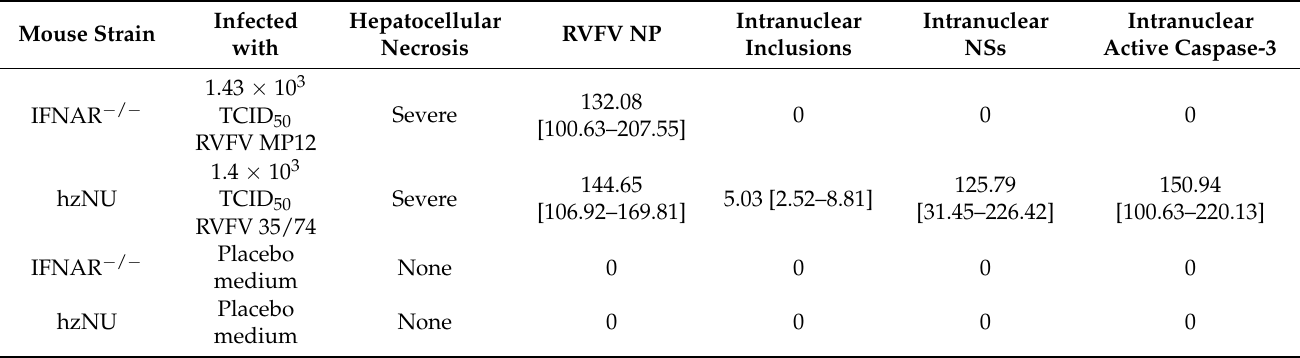
Table 3. Summarized histological and immunohistological